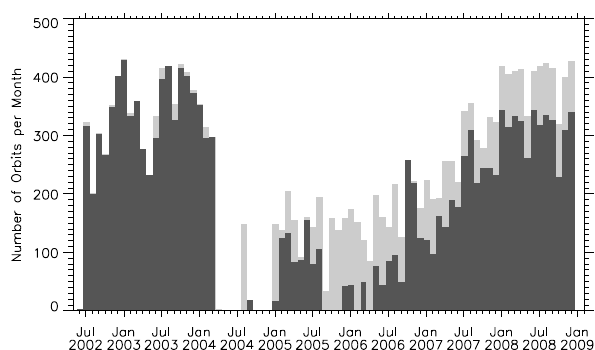
Fig. 4. Distribution of the number of Level 1b orbits per month processed in the MIPAS2D (black), and of the total number of available Level 1b orbits (gray). Note that the total number of Level 1b orbits include also the special observation